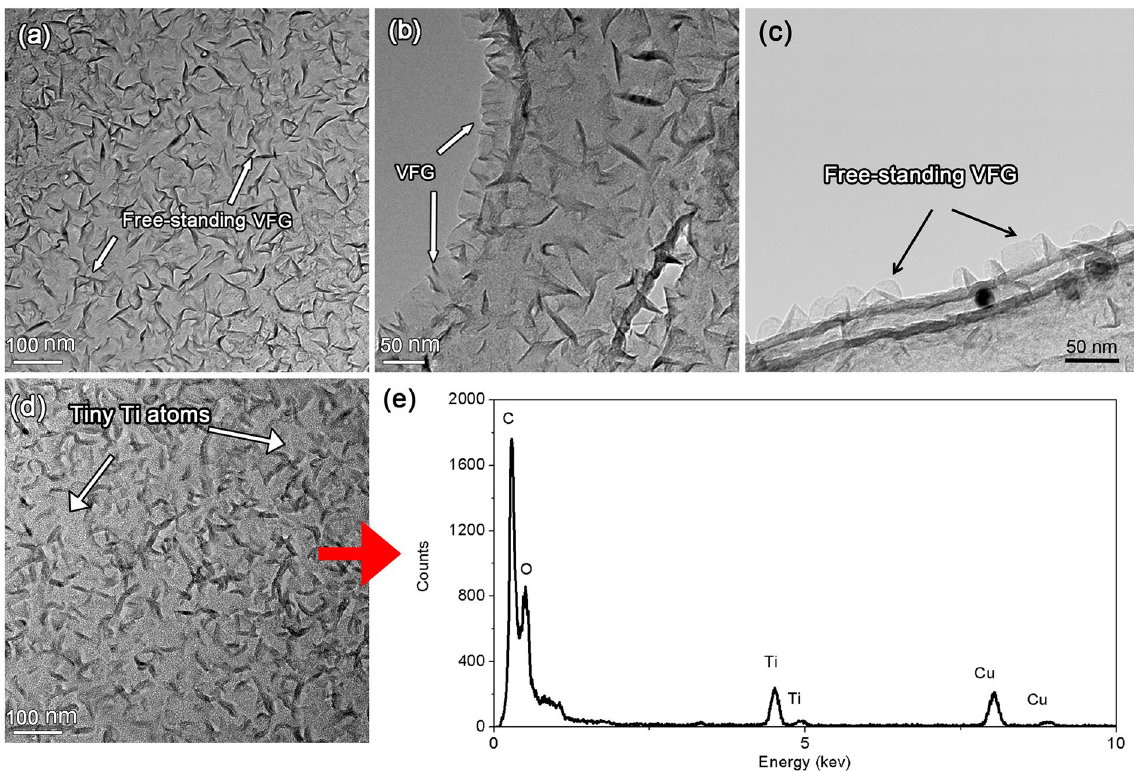
Figure 6. TEM image of VFG grown directly on a carbon coated micro-grid before and after the deposition of Ti: ( a,b ) and ( c ) before the deposition of Ti, ( d ) after the deposition of Ti, and ( e ) corresponding EDS result for the VFG after the deposition of